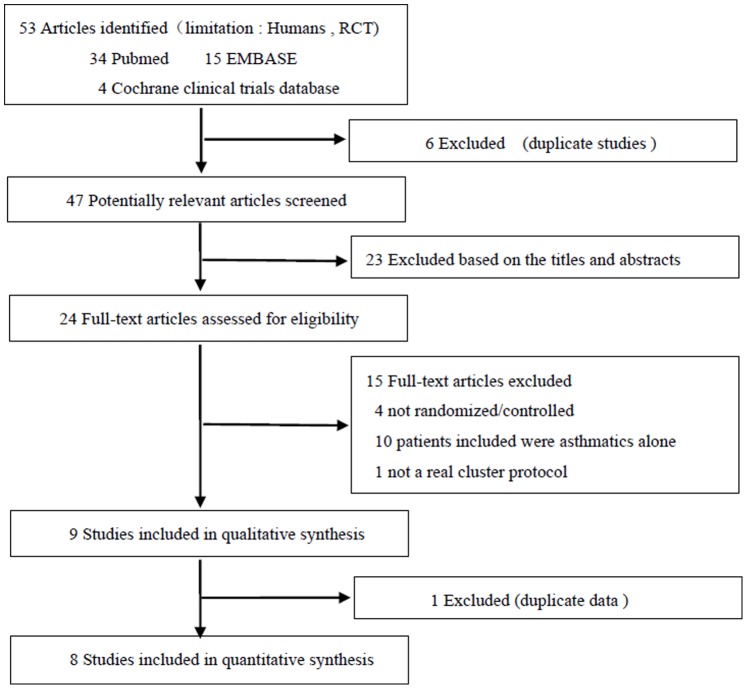
Flowchart of studies included.RCT, randomized controlled trial.